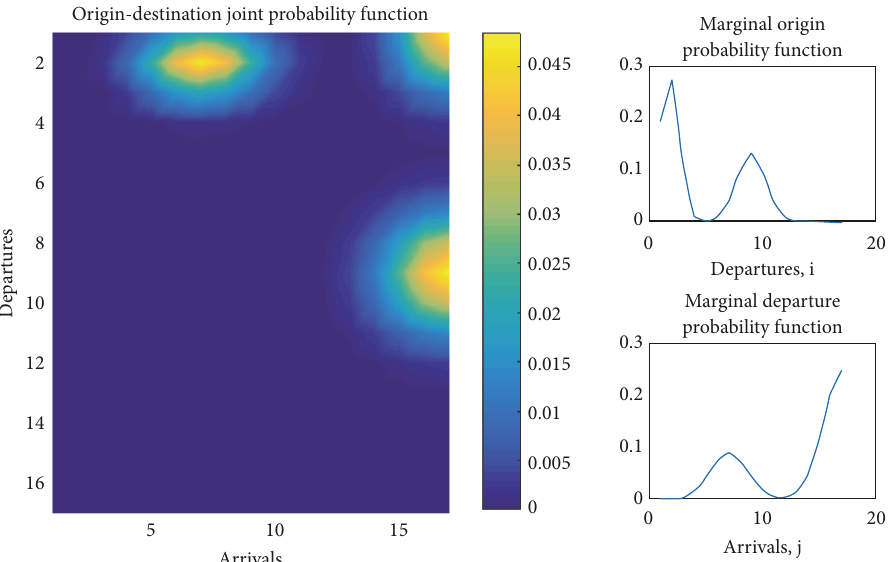
Figure 1: Example of the origin-destination joint probability function composed of 𝑀 = 3 two-dimensional Gaussian functions in a corridor with 17 stations.